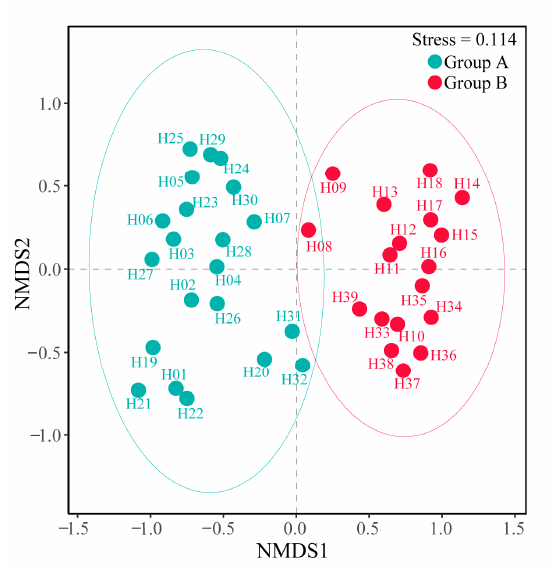
Figure 4. NMDS classi fi cation results of the fi sh communities based on the cluster analysis.